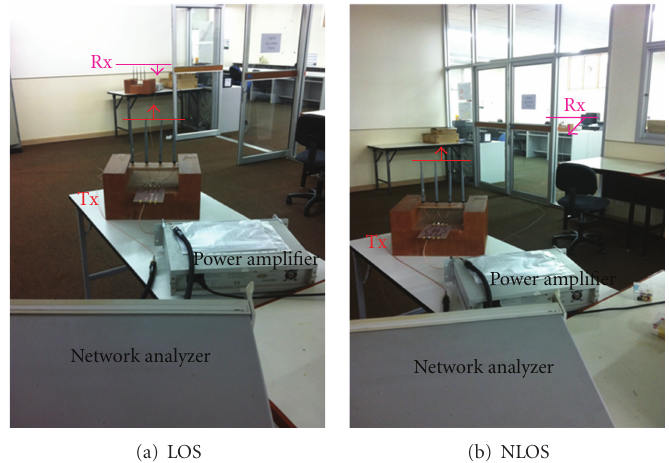
Figure 8: The photo of measurement areas for LOS and NLOS.